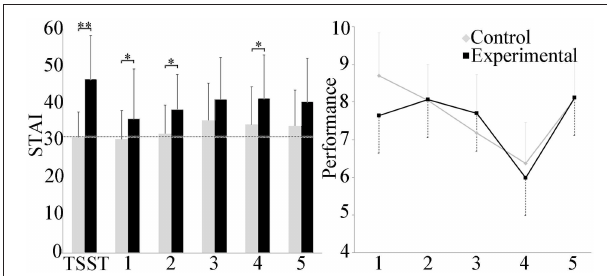
FIGURE 2 | Group differences in the STAI and performance score. The experimental group reported significantly higher self-reported stress after the TSST and scenarios 1, 2, and 4 than the control group. Average baseline for the cohort is shown in the dashed line. Performance in scenario decreased linearly with the exception of scenario 5 and was similar for both groups. * p ≤ 0 . 05 ; ** p ≤ 0 . 001 .